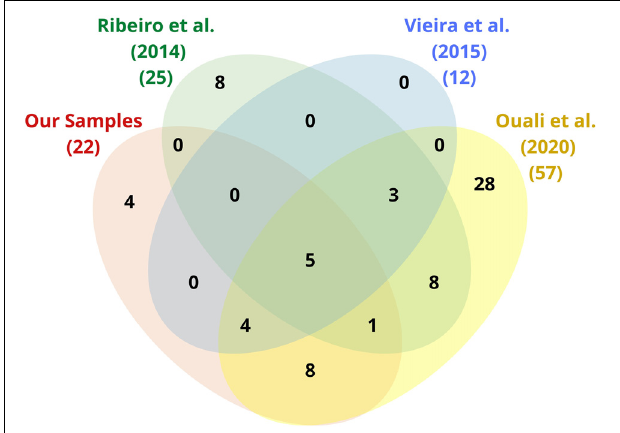
FIGURE 4 | Venn diagram of the immune-related genes found by mapping the sequences of our triatomine samples as well as those of Ribeiro et al. (2014), Vieira et al. (2015), and Ouali et al. (2020) by reference to IIID, KEGG, and NCBI (see Table 3 ).